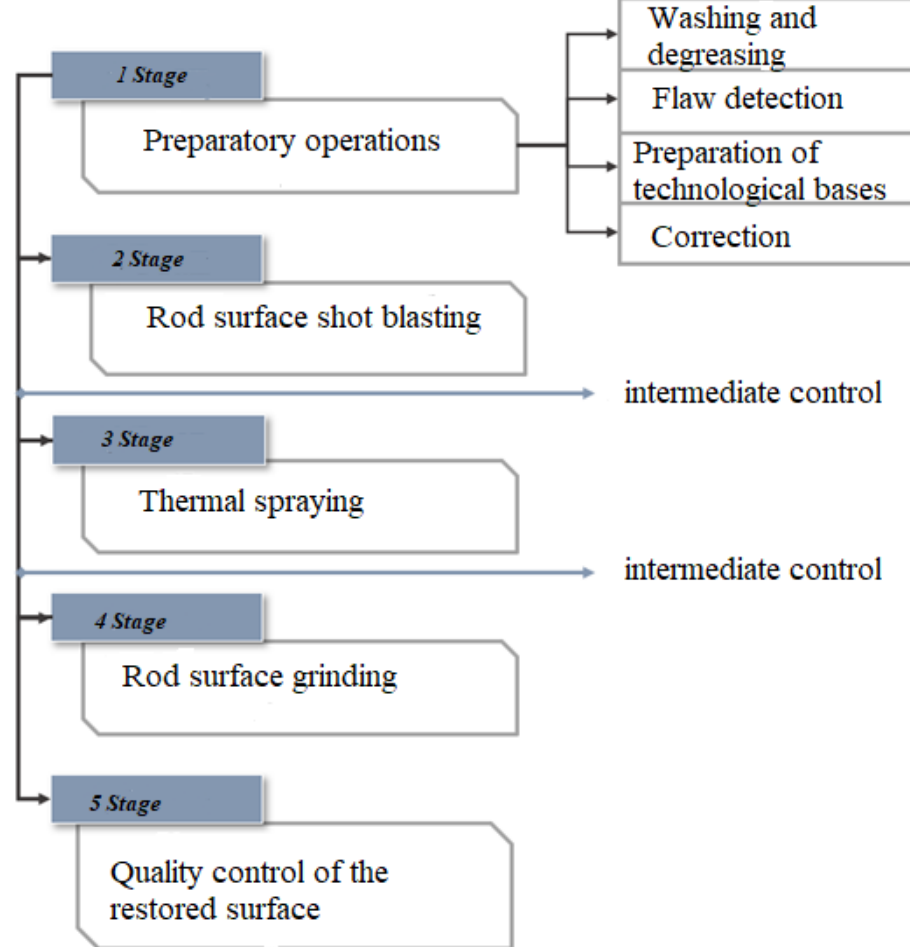
Figure 1. The technology of restoring the rod of a hydraulic cylinder by thermal spraying.